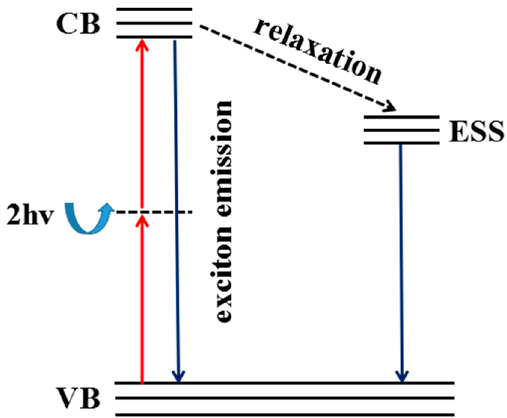
Figure 10. Energy level diagram of the perovskite molecule. VB, valence band; CB, conduction band; ESS, electron surface states.